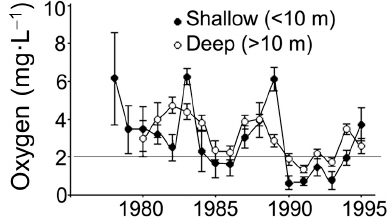
Figure 2. Bottom-water oxygen concentration (mg·L − 1 ) for shallow and deep water stations for combined observations from June, July, and August (mean ± 1 S.E.) 1978–1995. Source [16], derived from data in [24].